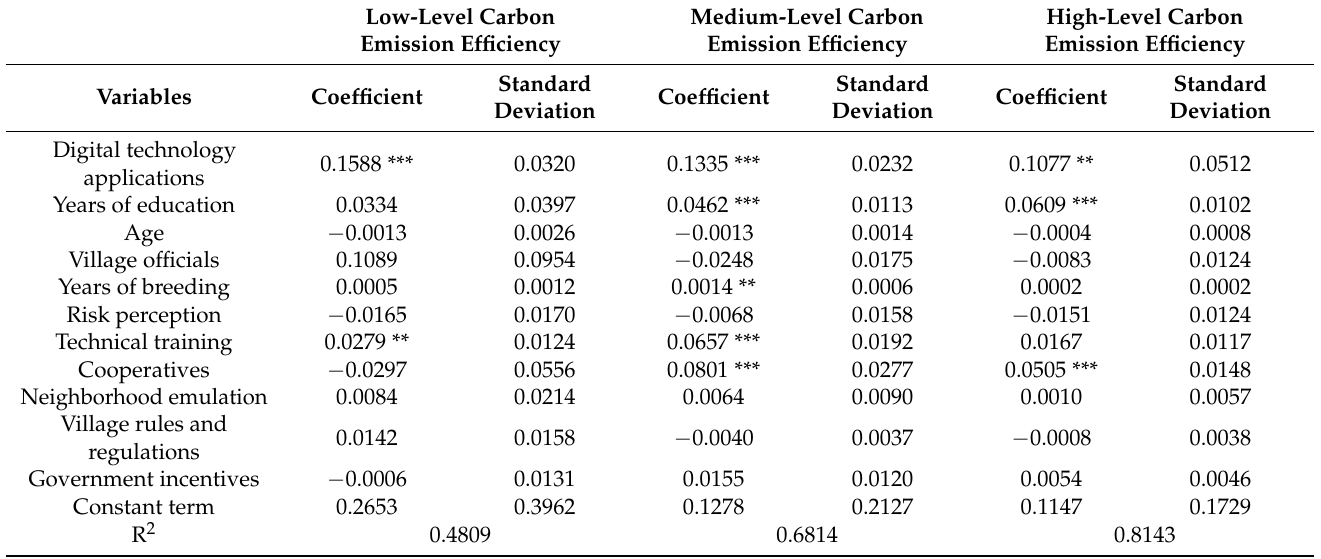
Table 9. The quantile regression